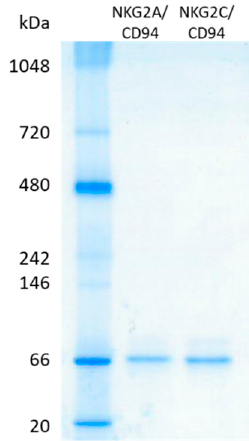
Figure A6. Native PAGE of purified sNKG2A/CD94 and sNKG2C/CD94. Purification of heterodimeric complex of NKG2A/CD94 and NKG2C/CD94 was examined via native PAGE. Clear bands were detected at the expected protein size.